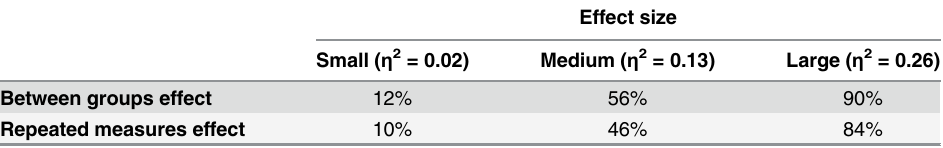
Table 2. Power achieved for three sizes of the effect, for between factors and repeated measures.